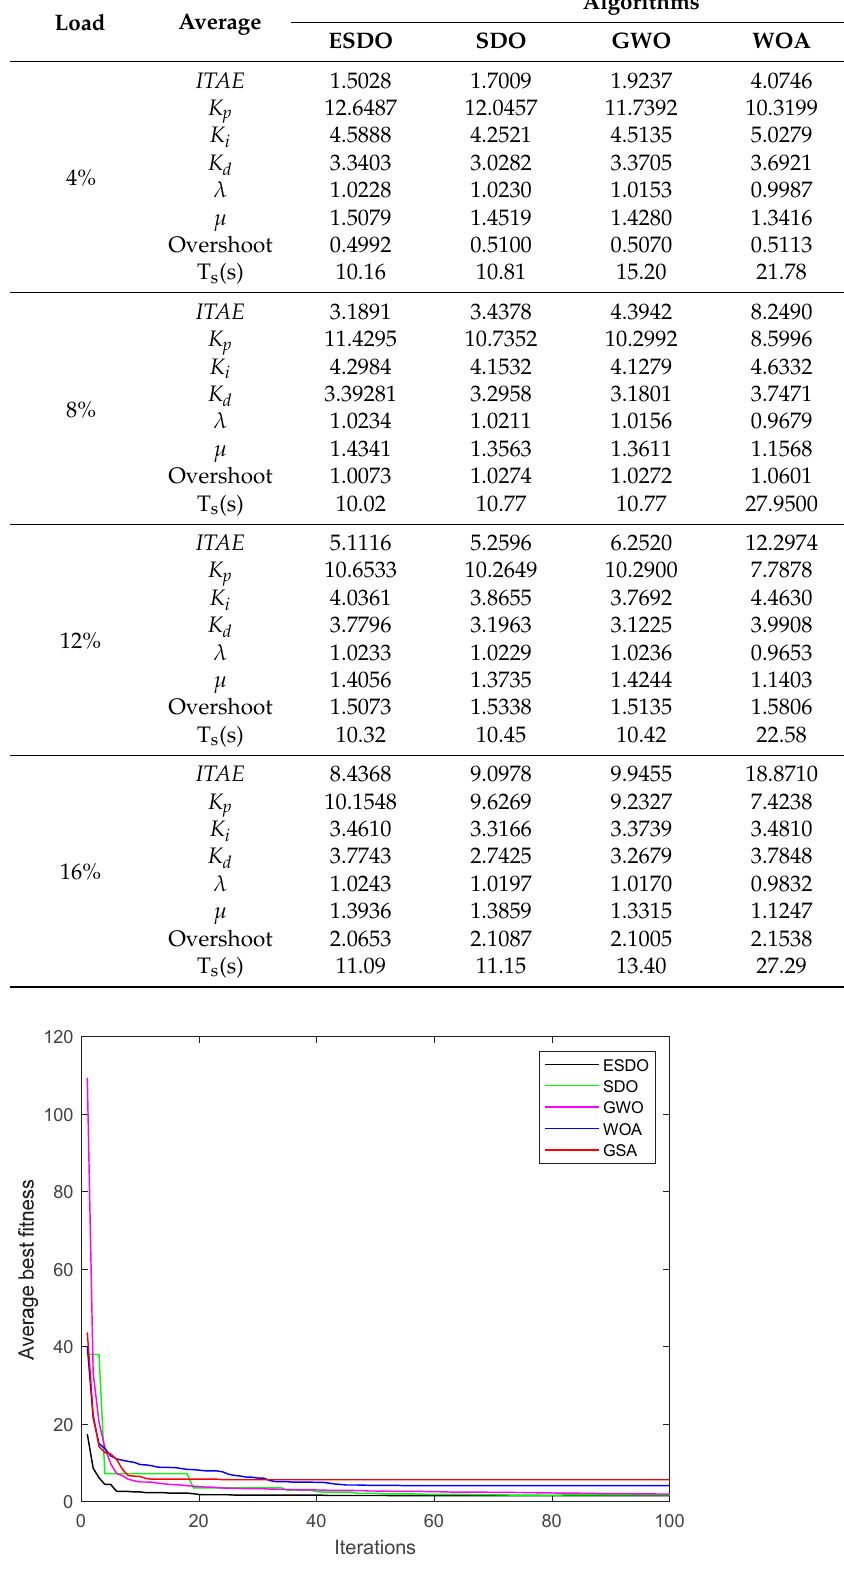
Figure 9. Convergence curves of average fitness with 4% load.